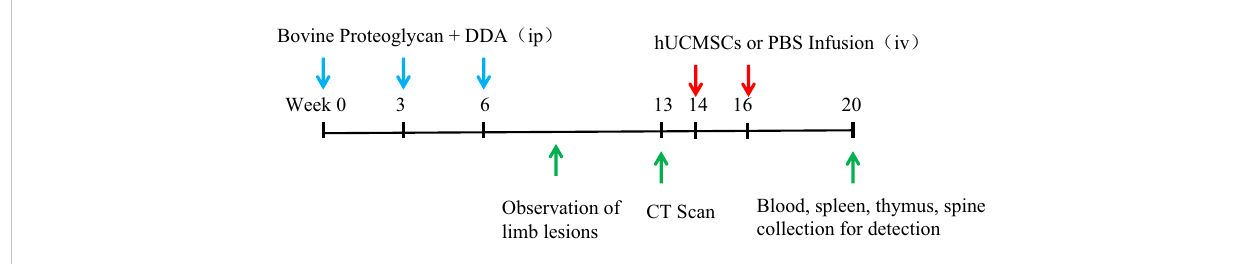
FIGURE 1 Schematic diagram of hUCMSCs treatment of AS. The blue arrows indicate the time points of administration of modeling reagents; The red arrows indicate the time points of administration of hUCMSCs or PBS; The green arrows indicate the time points of observation and